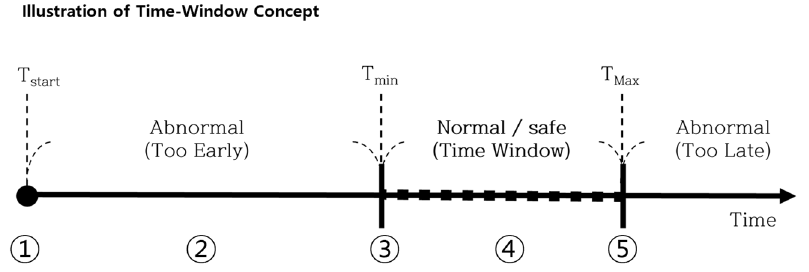
Figure 3. Visual illustration of the time-window. ① (T start ) is counted when the drone leaves a waypoint and starts to head to another. If the drone arrives the waypoint at ② , it is considered a too-early arrival, which is an abnormal situation. ③ is the minimum time boundary of a normal arrival. If the drone arrives at ④ , which is inside the normal boundary, it is considered a normal arrival and the drone would proceed to the next goal. As the drone passes ⑤ , which is the maximum time boundary, the time exceeds T max (max time), making the controller believe it is detecting an emergency and proceed with an emergency landing.